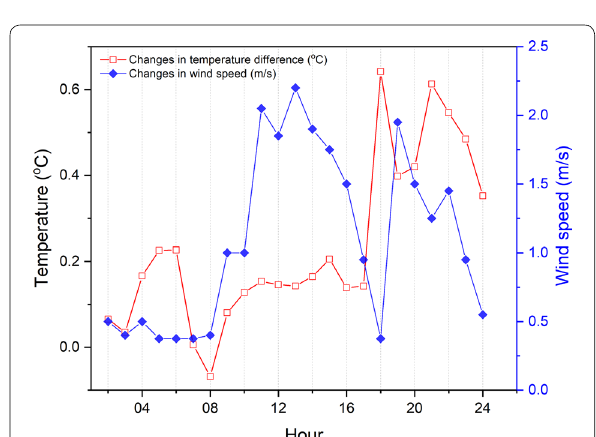
Fig. 9 Changes in the temperature difference (Built‑up minus Green) and wind speed between reduced wind speed case and base